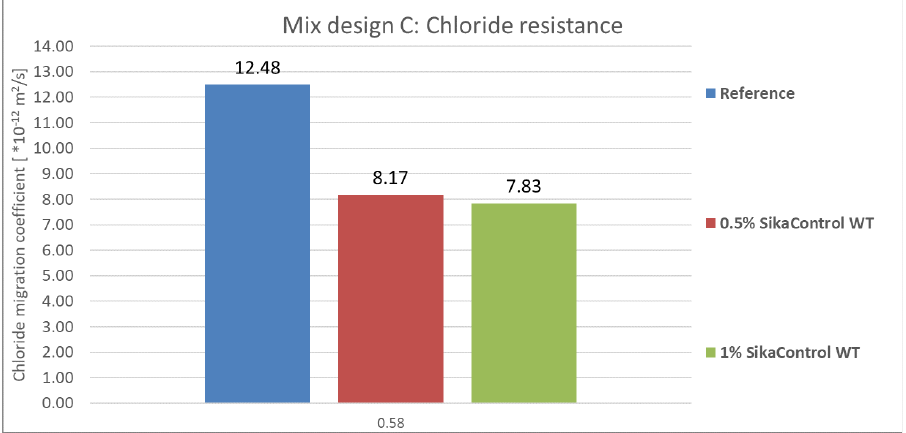
Figure 4. Mix design C: Chloride resistance.